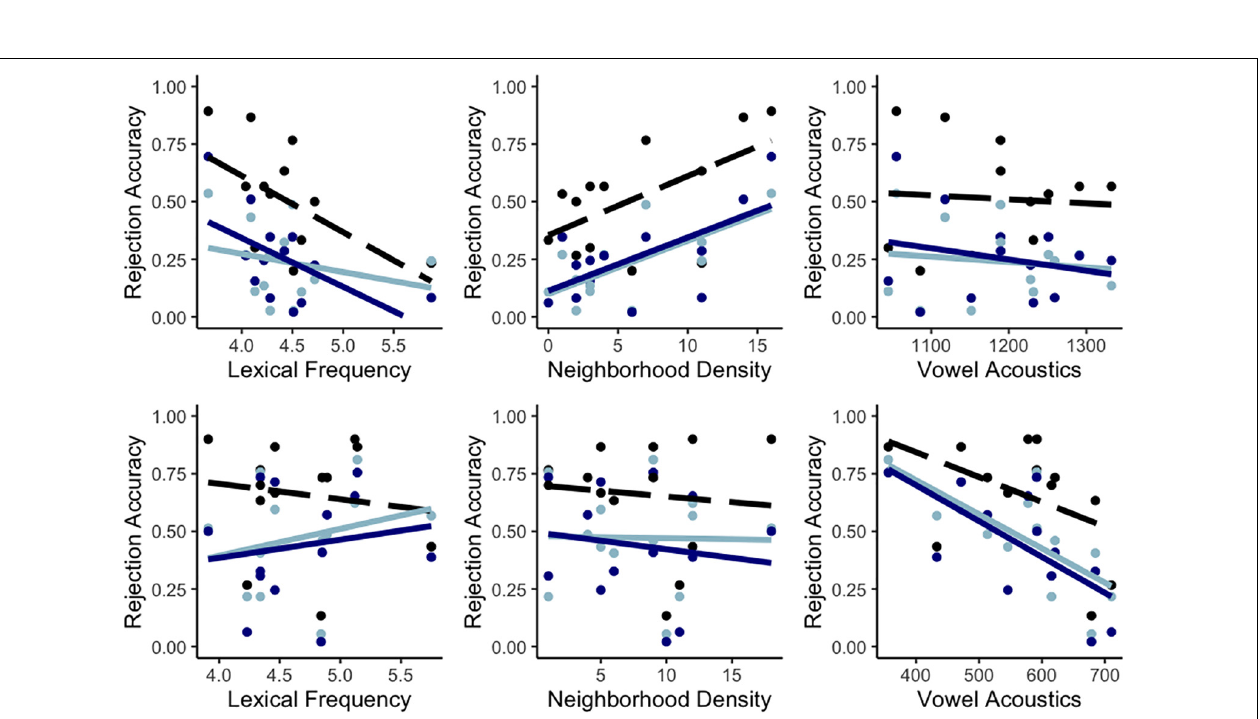
FIGURE 2 | Scatterplots of accuracy in nonword rejection for /æ/-nonwords (top row) and / ε /-nonwords (bottom row) as a function of lexical frequency (left), neighborhood density (center), and vowel acoustics (right) with data split by group. Advanced learners in Llompart (2021) are in black, intermediate learners in Llompart (2021) are in dark blue and intermediate learners in Llompart and Reinisch (2019b) are in light blue. Regression lines (advanced learners in dashed line, intermediate learners in solid lines) are provided for illustration purposes.